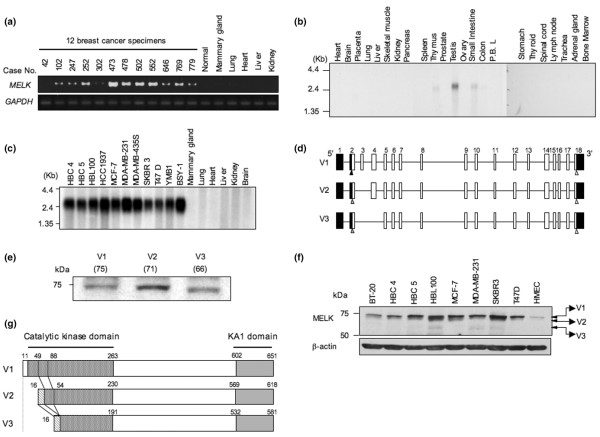
Expression and distribution of MELK in human normal tissues and breast cancer cell lines. (a) Expression of MELK in 12 breast cancer specimens (case number; 42, 102, 247, 252, 302, 473, 478, 502, 552, 646, 769 and 779) by semi-quantitative RT-PCR. GAPDH served as a quantitative internal control. (b) Multiple tissue Northern blot analysis demonstrated that an approximately 2.7 kb MELK transcript was detected in the testis, thymus and small intestine. PBL, peripheral blood leukocytes. (c) Breast cancer cell line Northern blot analysis revealed that approximately 2.4 to 2.7 kb MELK variants were specifically expressed in breast cancer cell lines, but not in normal vital organs. (d) Schematic representation of three variant transcripts identified by cDNA library screening (see Materials and methods). White boxes indicate a coding region and black boxes indicate a non-coding region. Black and grey triangles indicate initiation codons, and white triangles indicate stop codons. Exon numbers are shown above each box. (e) In vitro translation assay of each variant isolated from cDNA library screening. The number within parentheses represents the predicted molecular weight (kDa) of each variant protein. (f) Expression of MELK proteins in eight breast cancer cell lines as well as human mammary epithelial cells (HMECs) shown by western blot analysis with an anti-MELK antibody. β-Actin served as a control. (g) Schematic representation of the V1, V2 and V3 forms of MELK. The shaded boxes indicate the catalytic domain (amino acids 11 to 263 of the V1 protein). The KA1 domain is the kinase-associated domain in the carboxy-terminal region.